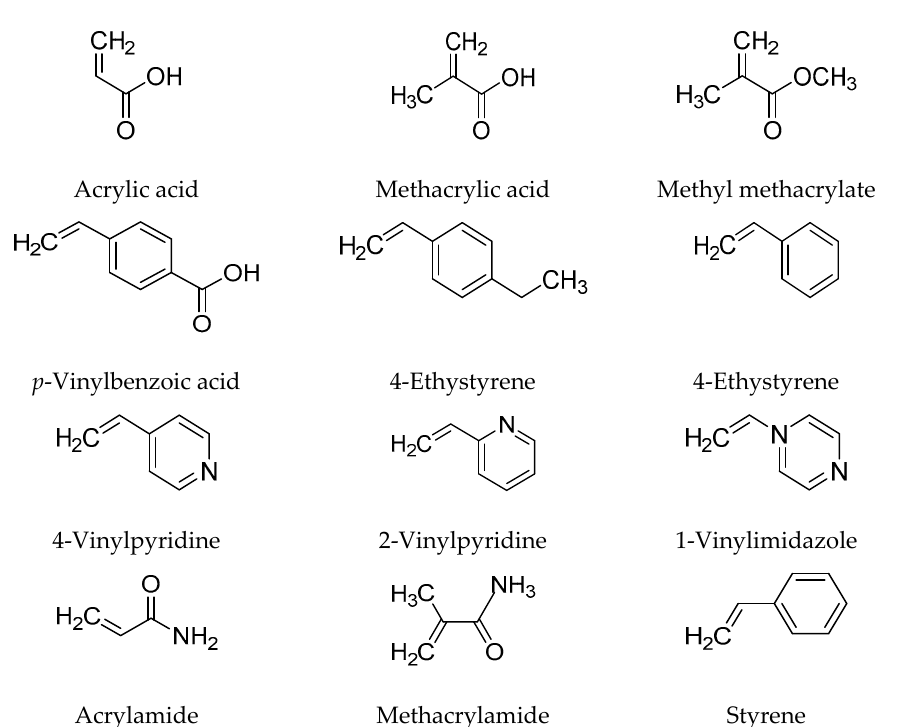
Figure 4. Scheme of commonly used monomers for non-covalent molecularly imprinted technique.